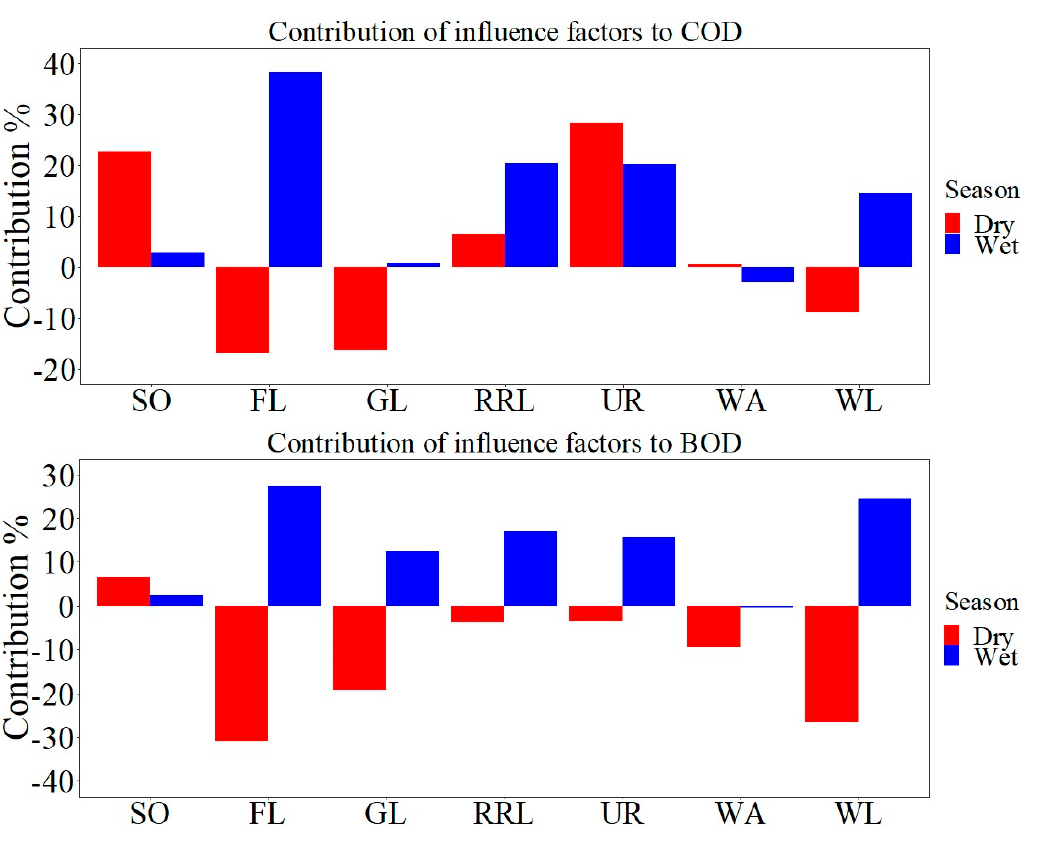
Figure 6. Contribution of influence factors to COD and BOD in dry and wet seasons. The SO, FL, GL, RRL, UR, WA and WL are sewage outfalls, farmland, grassland, rural residential land, urban, water and woodland, respectively.